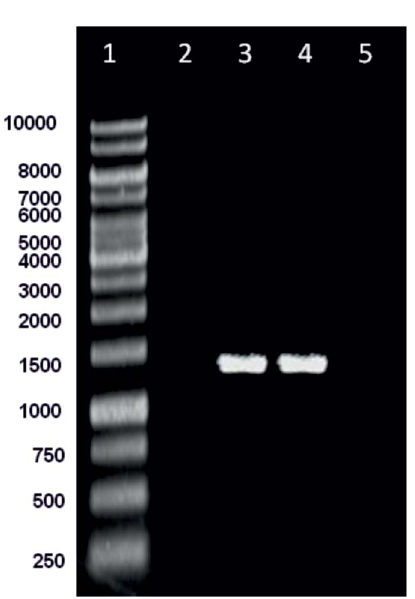
Fig. 1. PCR analysis of the 16Sr RNA gene of Klebsiella pneumoniae subsp. ozaenae isolated in the current study. Lanes are: (1) Molecular marker, (2) negative urine isolate for 16Sr RNA gene (3,4): positive blood and stool K. ozaenae isolates for 16Sr RNA gene (5) negative control. Product expected size is 1413 bp.